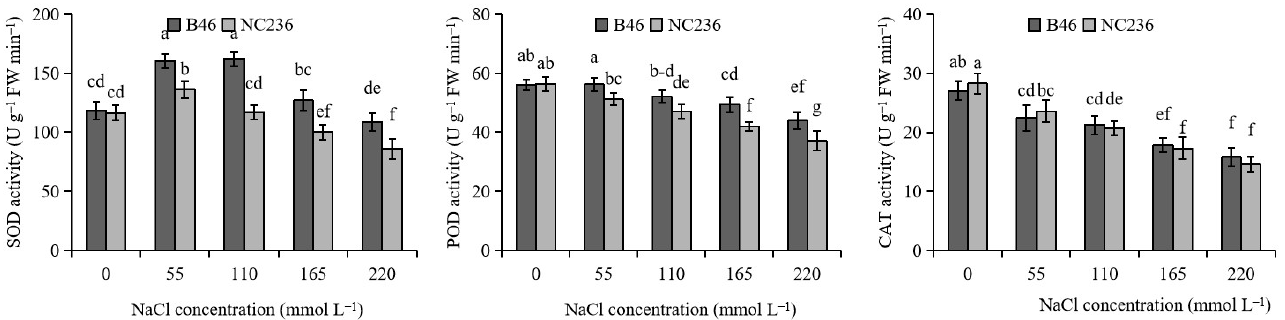
Figure 2. Effect of salt stress on the activities of SOD, POD, and CAT in maize leaves. Data are expressed as mean ± standard deviation. Different letters within the same column indicate significant difference at the 5% level.